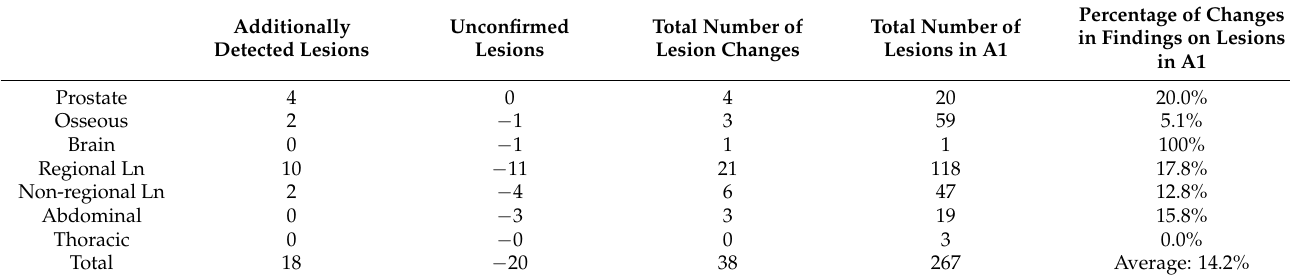
Figure 4. 68 Ga-PSMA-PET/CT lesions in PCa patients. Abbreviation: Ln: lymph node.